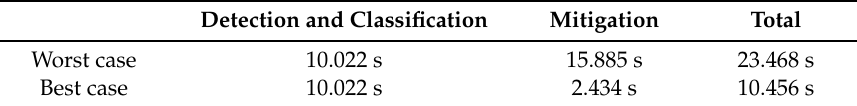
Table 9. Worst and best cases of ransomware detection and mitigation times.